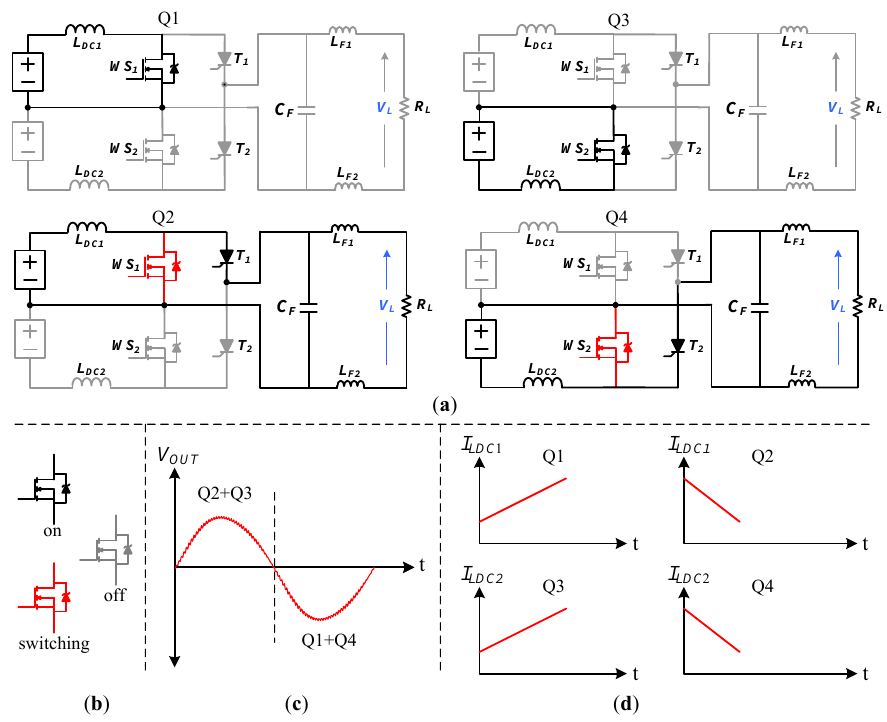
Figure 4. The switching states of the half-bridge CSI, ( a ) operation modes ( b ) conduction modes ( c ) V out including operation modes and ( d ) current on the inductors L 1 and L 2